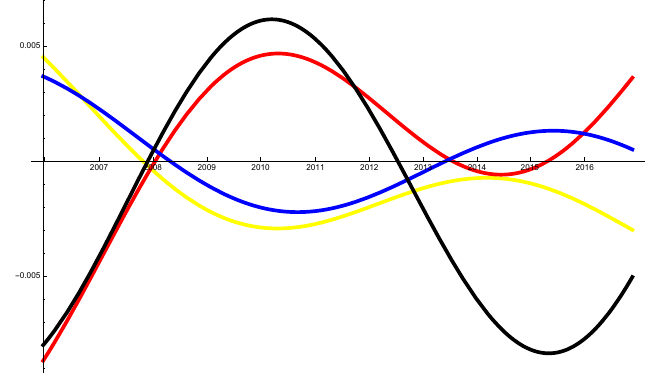
Figure 3. The x -axis represents time. The y -axis represents the value of the interaction coefficients of SOLAR (yellow), WIND (blue), WTI (black), and TECH (red) between 2006 and